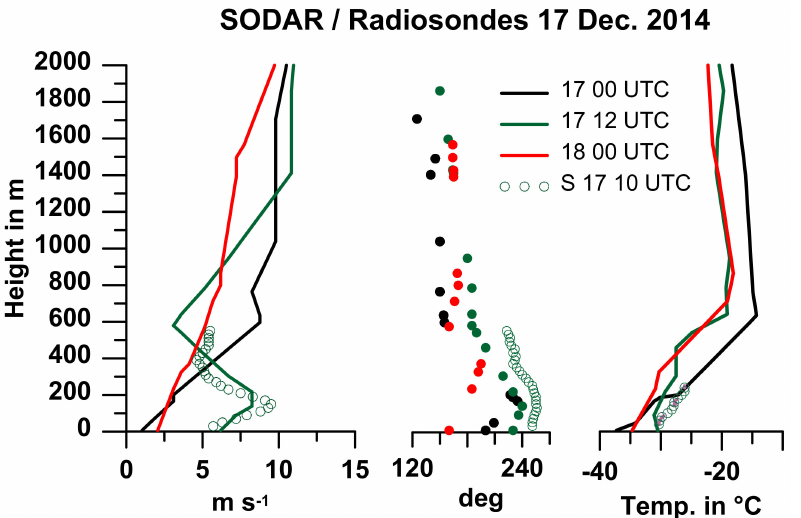
Figure 11. Vertical profiles from radiosondes of the wind speed ( left ), wind direction ( middle ) and temperature ( right ) for 17 December 2014 0000 UTC (black) and 1200 UTC (green) and 18 December 0000 UTC (red). The data of the SODAR/RASS for 1000 UTC are shown as open dots (only every second point). Note that the radiosondes are launched about 1–2 hours before their nominal time.